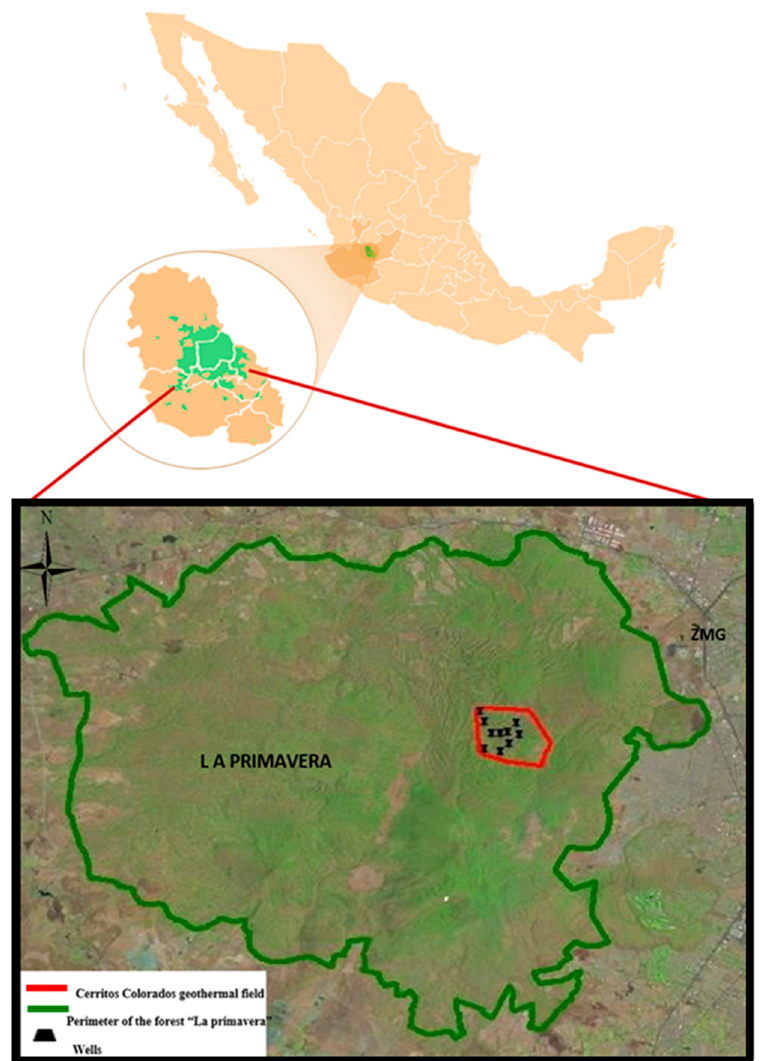
Figure 5. Location map of the Cerritos Colorado geothermal field [30].